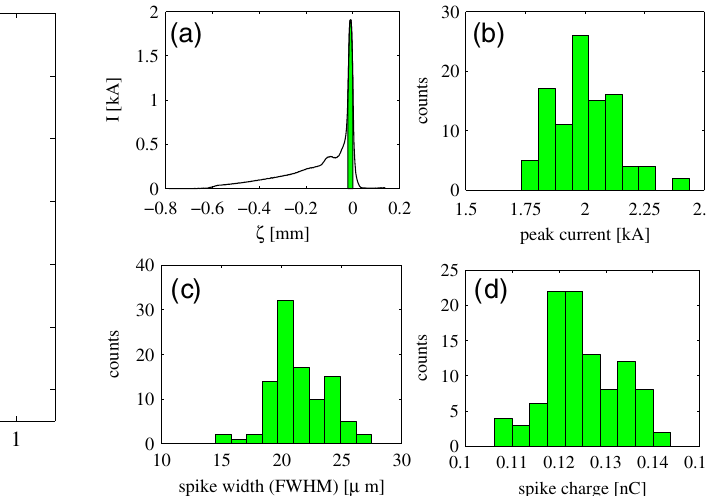
FIG. 11. (Color) Phase space ellipses of single slices in the tail, center, and head of an uncompressed bunch. The coordinates ½h x ð (cid:2) Þi ; h x 0 ð (cid:2) Þi(cid:4) of the slice centroids are indicated by x marks. misalignments of the slice ellipses with respect to each other, and a (cid:2) dependence of the slice centroid coordinates h x ð (cid:2) Þi and h x 0 ð (cid:2) Þi , see Fig. 11. Eliminating the contribution from centroid shifts, the projected emittance drops to 2 : 5 (cid:1) m , showing that centroid shifts are the dominant source for the observed projected emittance growth.